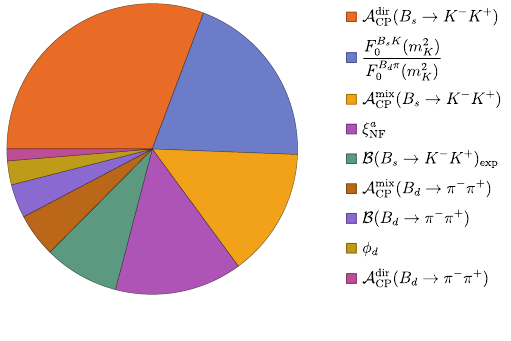
Figure 4 . Relative contributions to the uncertainty of the value of φ s in eq.